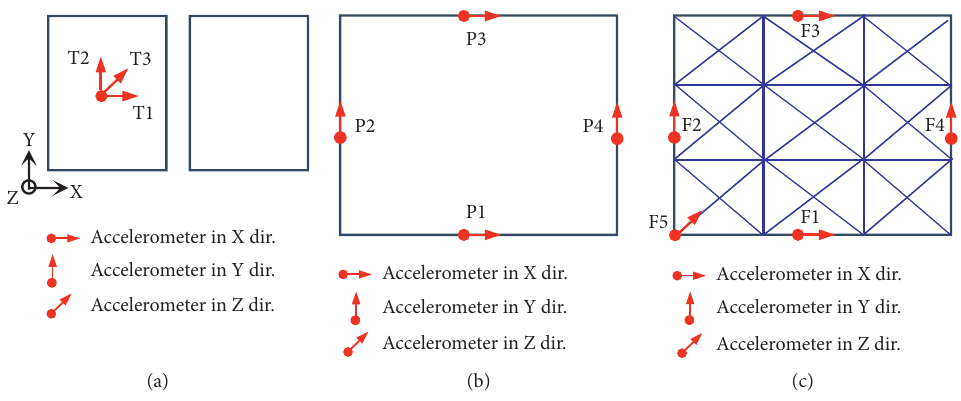
Figure 6: Accelerometers on the platform. (a) Table level, (b) ceiling level, and (c) floor